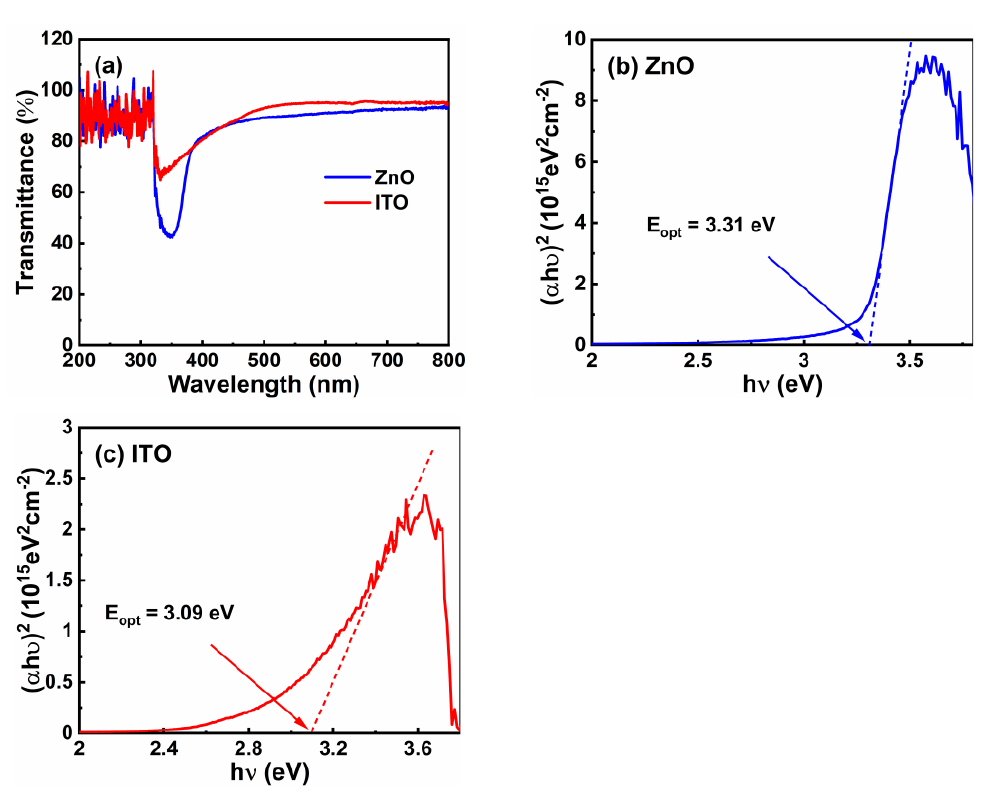
Figure 2. ( a ) Transmittance of ZnO and ITO films. ( α h ν ) 2 -h ν curves of ( b ) ZnO and ( c ) ITO films. ZnO and ITO films were deposited on glass substrates.